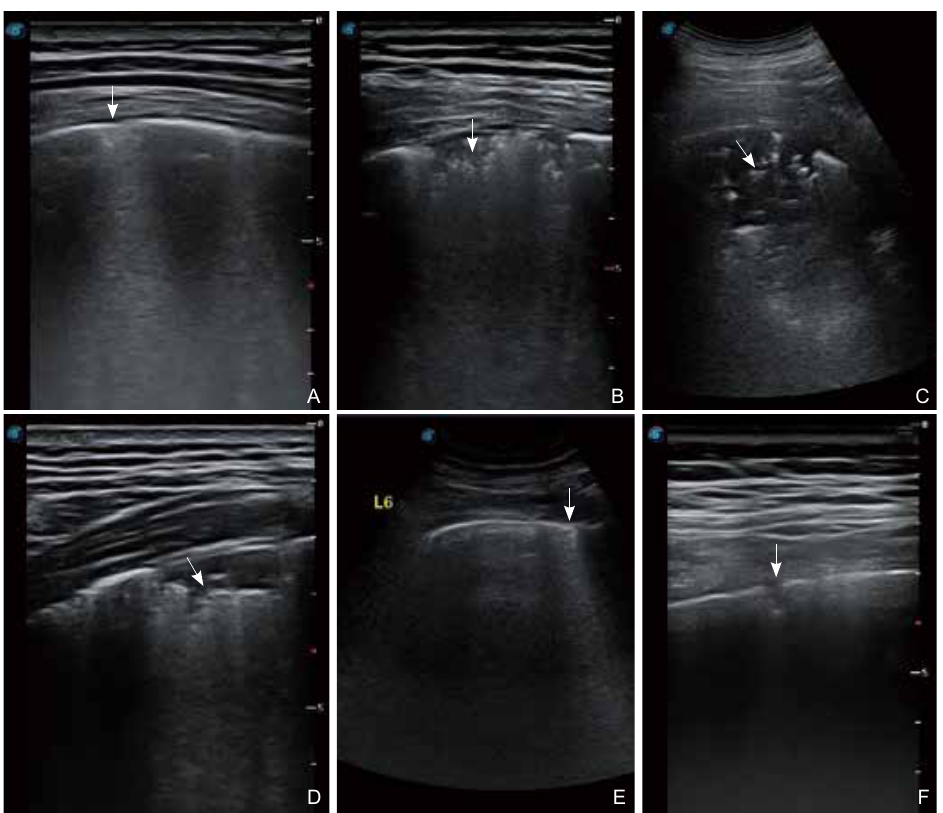
Figure 1 Image examples of the ultrasonic signs of COVID-19 patients. (A) Peripheral B-line and waterfall signs, unsmooth pleural line (arrow). (B) The interrupted pleural line with strip-like solid lesion. (C) A large tissue consolidation with air bronchogram (arrow), and the pleural line was interrupted. (D) Interrupted pleural line with striate consolidation shadows under the pleura, and the alveolar inflation signs in the bronchioles (arrow). (E) Unsmooth pleural line with peripheral B-line (arrow). (F) Small patchy lesions in peripheral lung